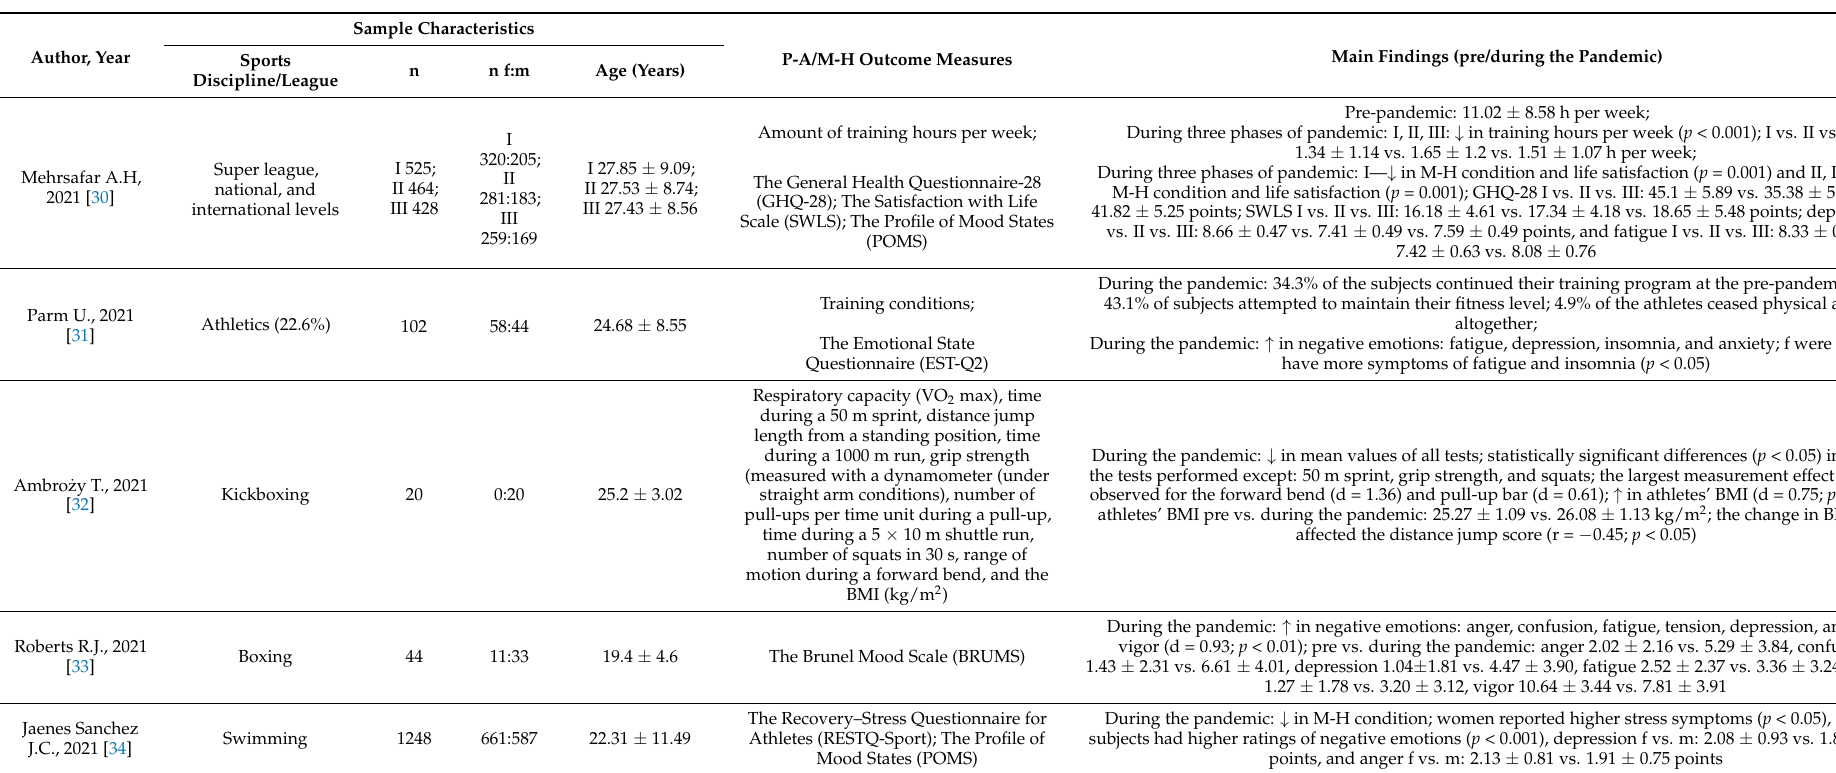
The Recovery–Stress Questionnaire for During the pandemic: ↓ in M-H condition; women reported higher stress symptoms ( p < 0.05), female Athletes (RESTQ-Sport); The Profile of subjects had higher ratings of negative emotions ( p < 0.001), depression f vs. m: 2.08 ± 0.93 vs. 1.87 ± 0.87 Mood States (POMS) points, and anger f vs. m: 2.13 ± 0.81 vs. 1.91 ± 0.75